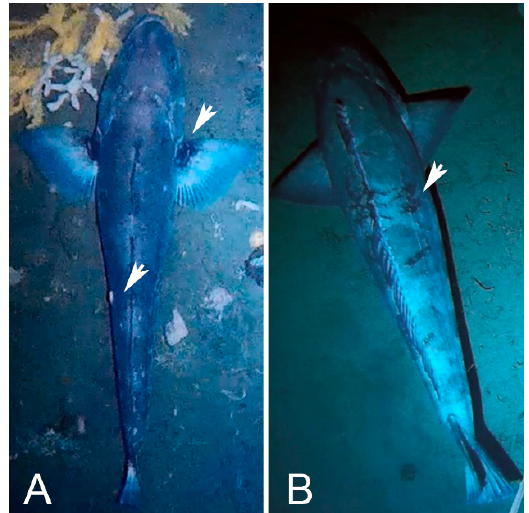
Figure 4. Examples of identifying marks on toothfish individuals. (A) Distinctive colour pattern of the pectoral fins and presence of a parasite on the left side of the trunk. (B) Dark spot pattern along the body.